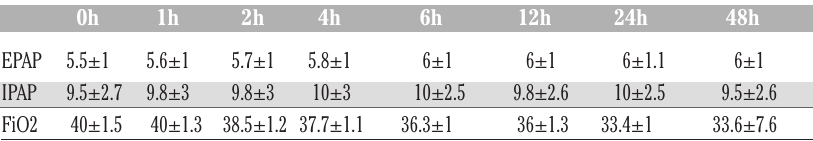
Table 1. Non-invasive ventilation parameters